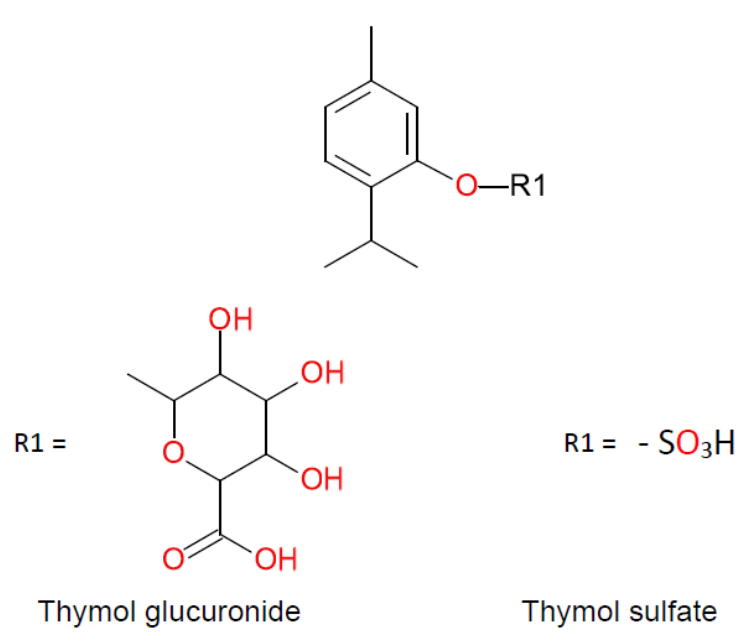
Figure 3. Thymol Figure 3. Thymol metabolites.